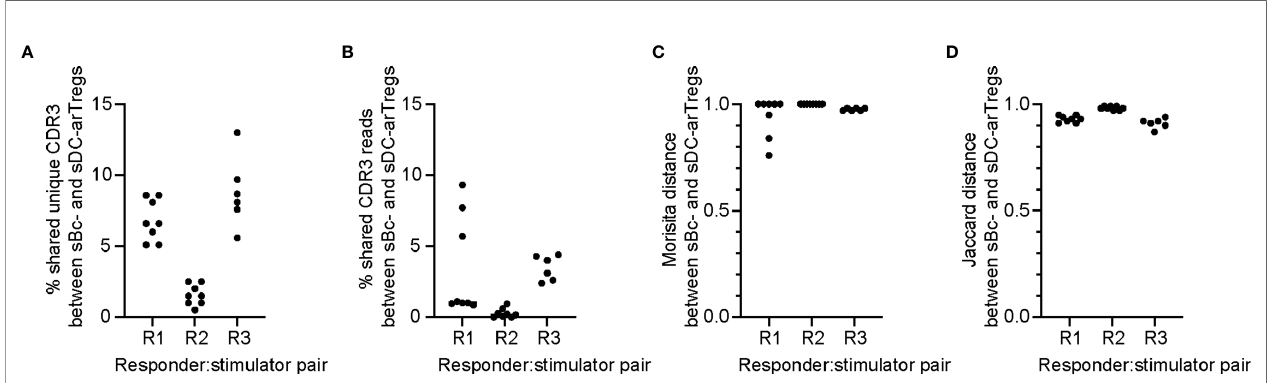
FIGURE 6 | sBc- and sDC-arTregs stimulate distinct TCR repertoire likely in part due to diversity of the circulating Tregs. On d0, 2-4 replicate culture wells were set up using the same responder:stimulator combinations (R1, R2, and R3). Cytokine-matured monocyte-derived DCs were used to stimulate responder 1 and 2, and MPLA-matured monocyte-derived DCs were used to stimulate responder 3. On d11, RNA was isolated from the arTregs in each well (~500,000). RNA from ~250,000 cells was TCR b sequenced with a read depth of 1 million. For each responder:stimulator combination, the top 100 CDR3s between sBc- and sDC- arTregs were compared. All possible sBc- and sDC-arTreg combinations within the same responder: stimulator pair were compared. Each comparison is represented by one dot. (A) Percentage shared unique CDR3, (B) percentage shared CDR3 reads, (C) Morisita distance comparing CDR3 usage, and (D) Jaccard distance comparing CDR3 usage were calculated between sBc- and